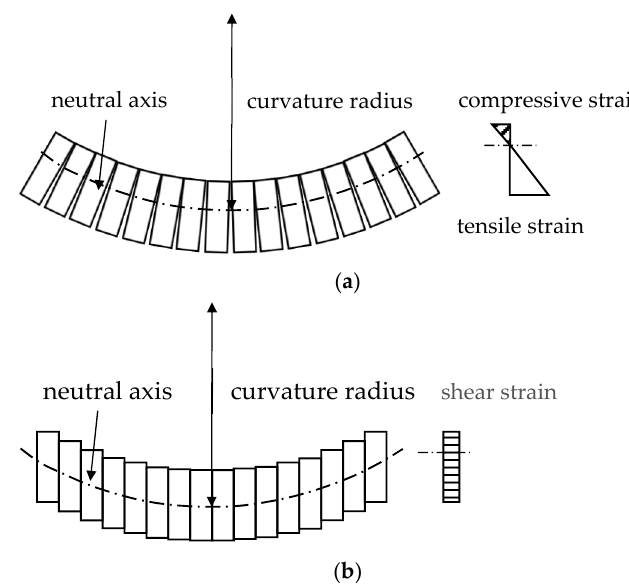
Figure 1. The two longitudinal deformation modes of a shield tunnel. ( a ) Bending mode; ( b ) Dislocation mode.